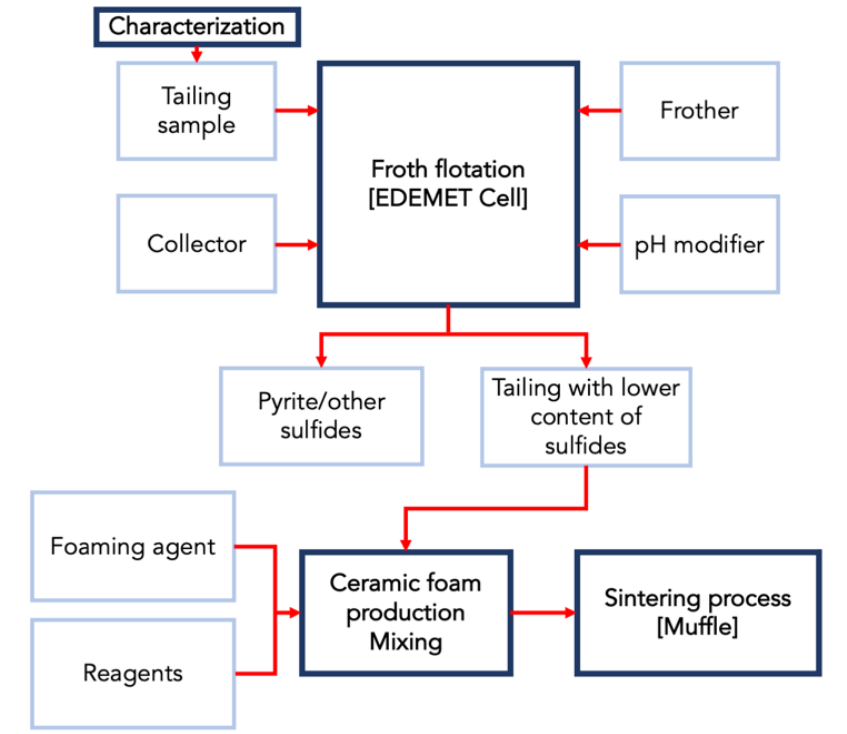
Figure 1. Process of manufacturing of ceramic foams.